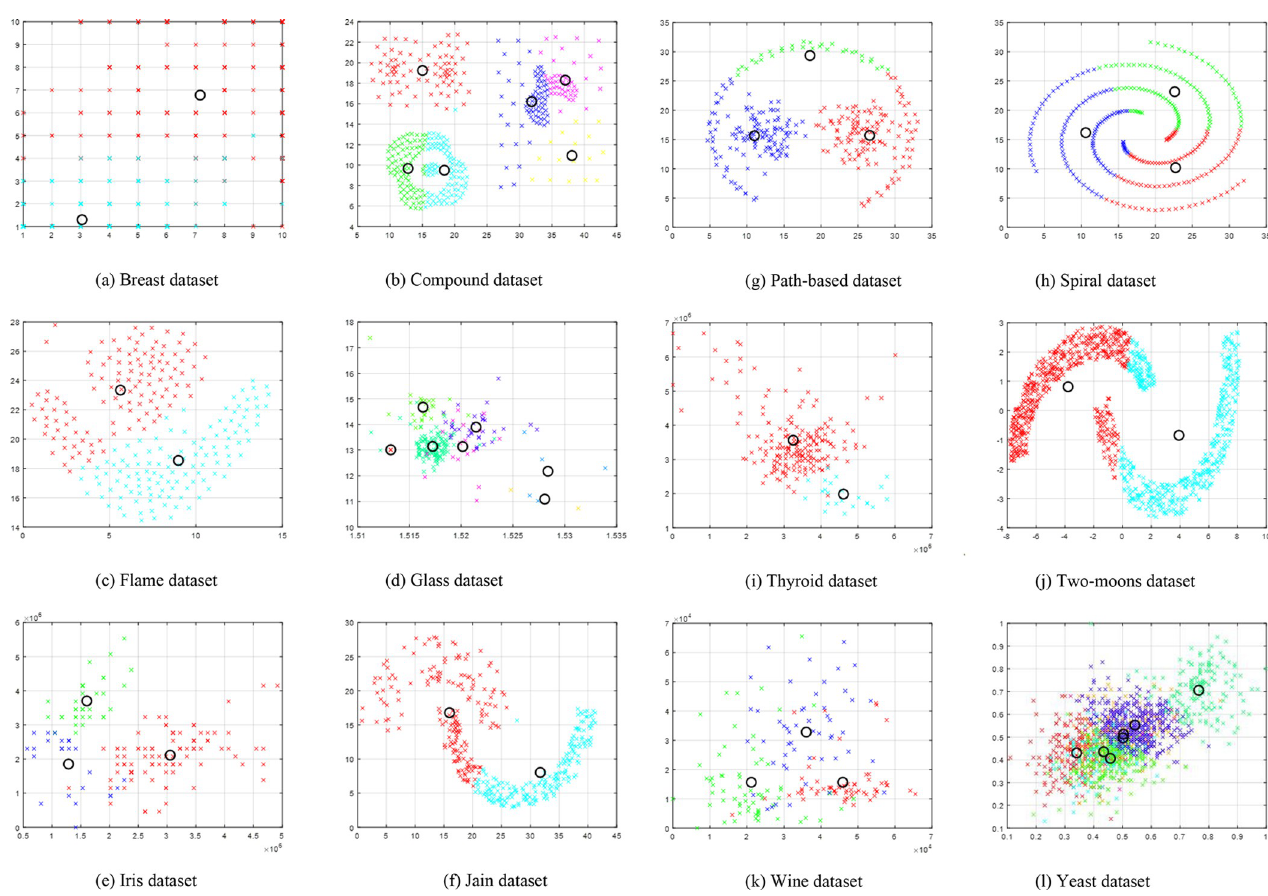
Fig 3. Clustering illustration of hybrid SOSK-means for the listed datasets using